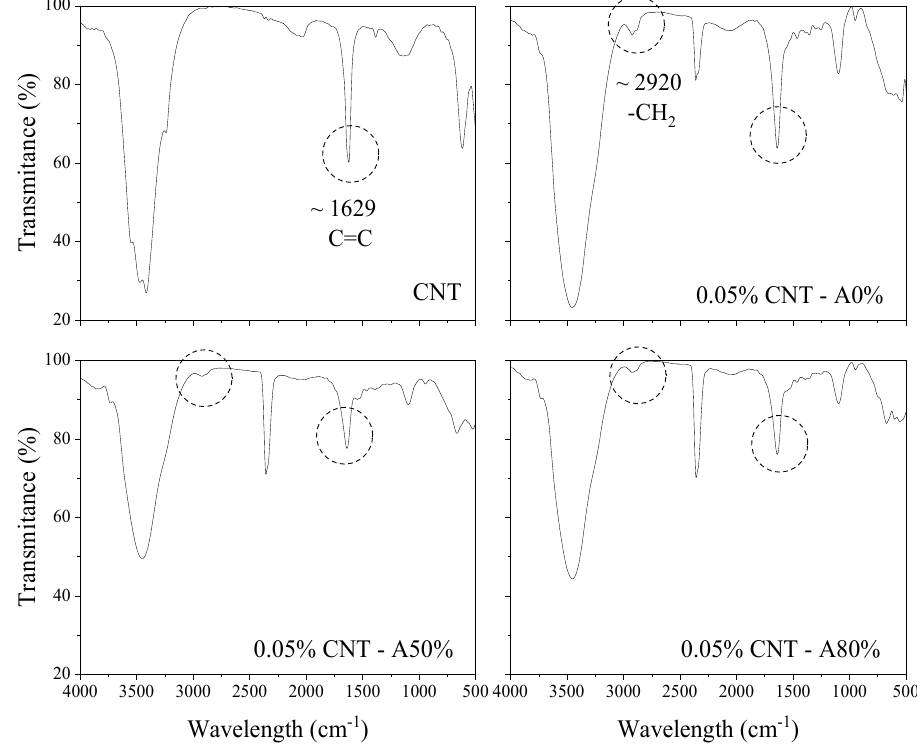
Figure 5. FTIR spectra of polycarboxylate-based superplasticizer and 0.05% CNT dispersions.